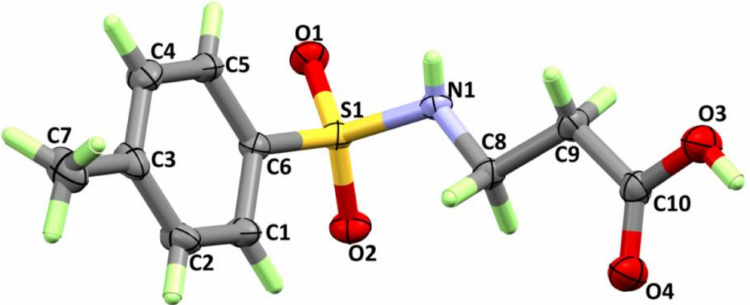
Figure 1. Atom numbering and thermal ellipsoids at a 30% probability level for 4b